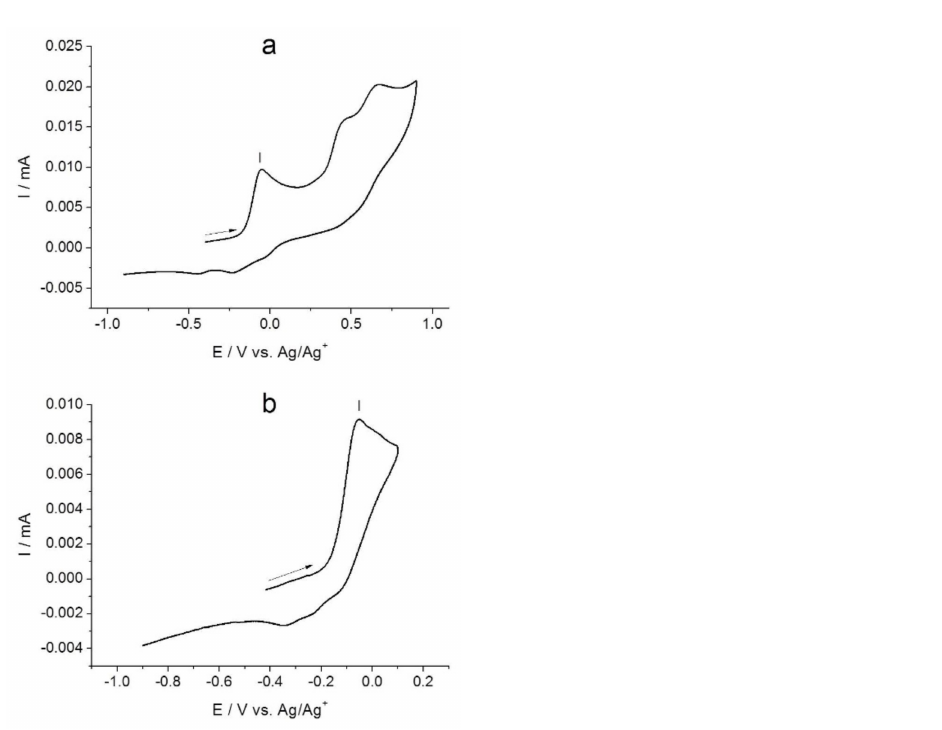
Figure 2. Cyclic voltammograms of a glassy carbon electrode (0.07 cm 2 ) in 0.001 mol L − 1 solution of [NiAmben] in 0.1 M Et 4 NBF 4 /DMSO at a scan rate of 0.05 V s − 1 : ( a ) between − 0.9 and 0.9 V; ( b ) between − 0.9 and 0.1